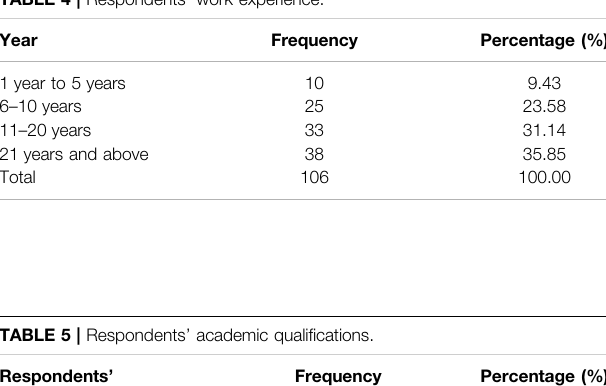
TABLE 4 | Respondents ’ work experience.